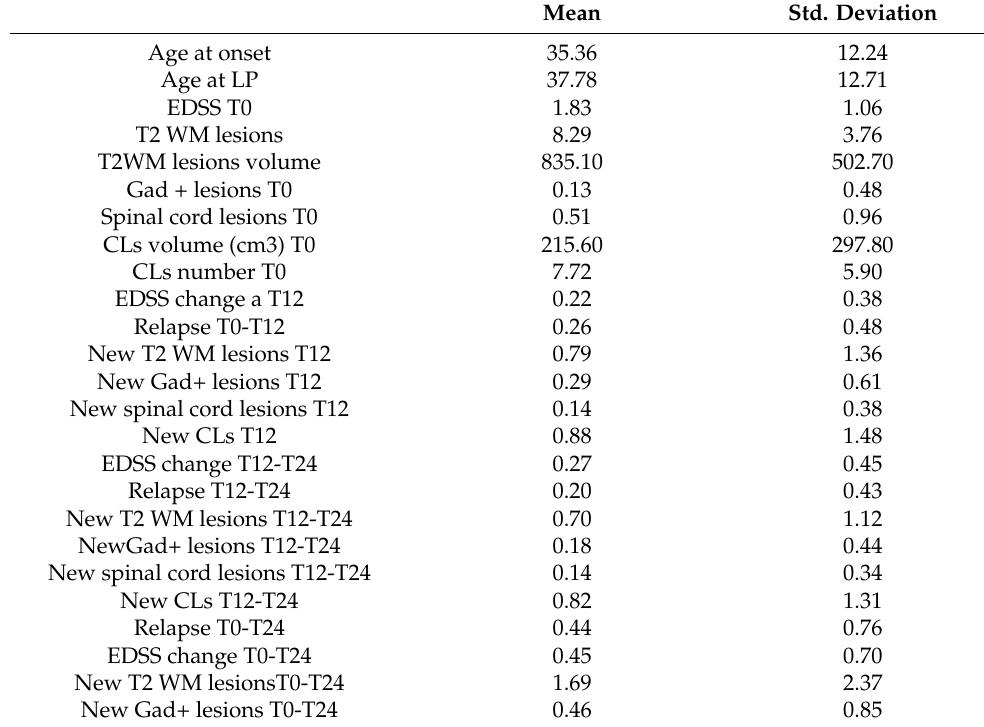
Table 1. Demographic, clinical and MRI details of the MS examined